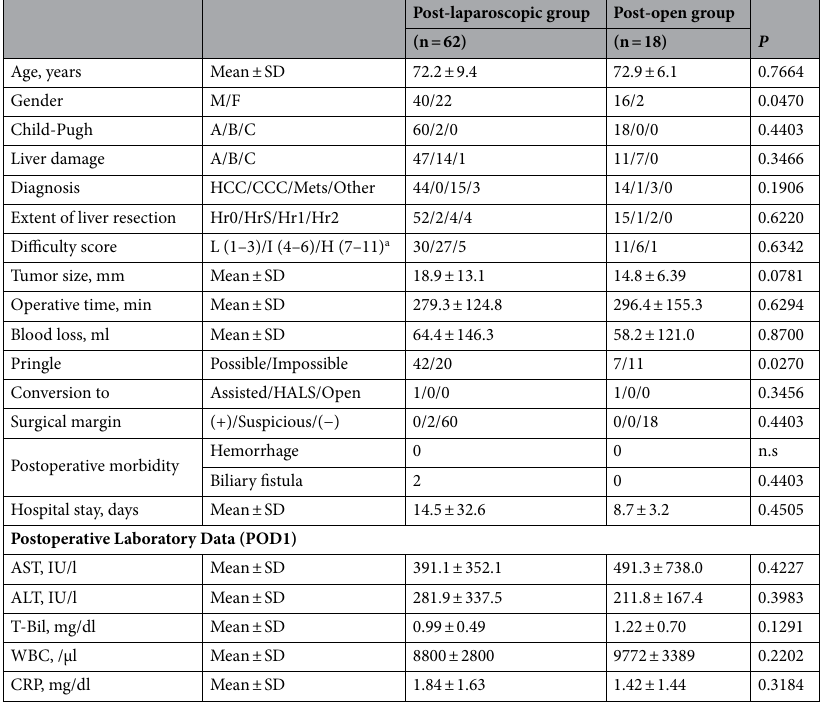
Table 2. Patient characteristics and surgical results of laparoscopic repeat hepatectomy classified by the last hepatectomy. HCC hepatocellular carcinoma, CCC cholangiocellular carcinoma, Mets metastasis, HALS hand- assisted laparoscopic surgery, n.s. not significant. a L: low, I: intermediate, H: